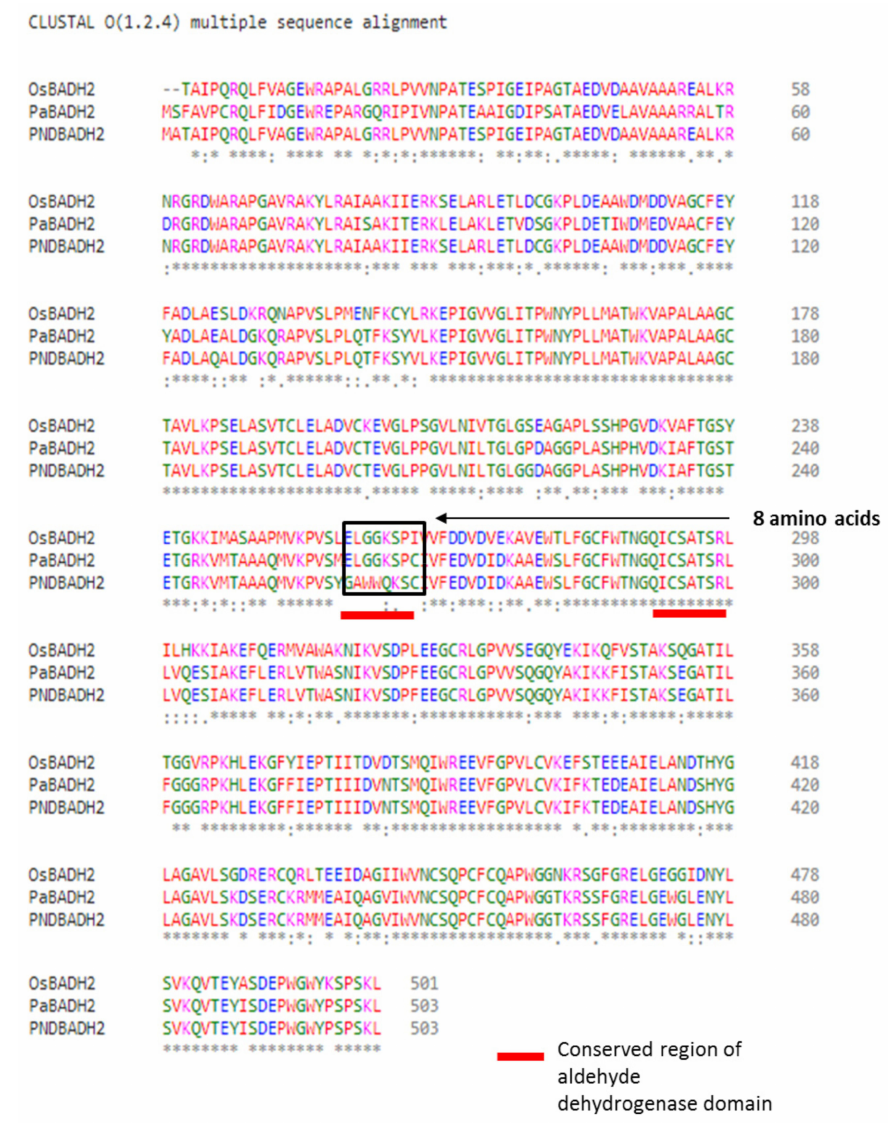
Figure 2. Multiple sequence alignment of BADH2 protein sequence from OsBADH2 (gene ID: 4345606), PND BADH2 (gene ID: KY765936.1), and PaBADH2. The marked region shows the continuous stretch of eight amino acid variations in PND BADH2, as compared with OsBADH2 and PaBADH2 sequences. The conserved region of the aldehyde dehydrogenase domain is represented with red